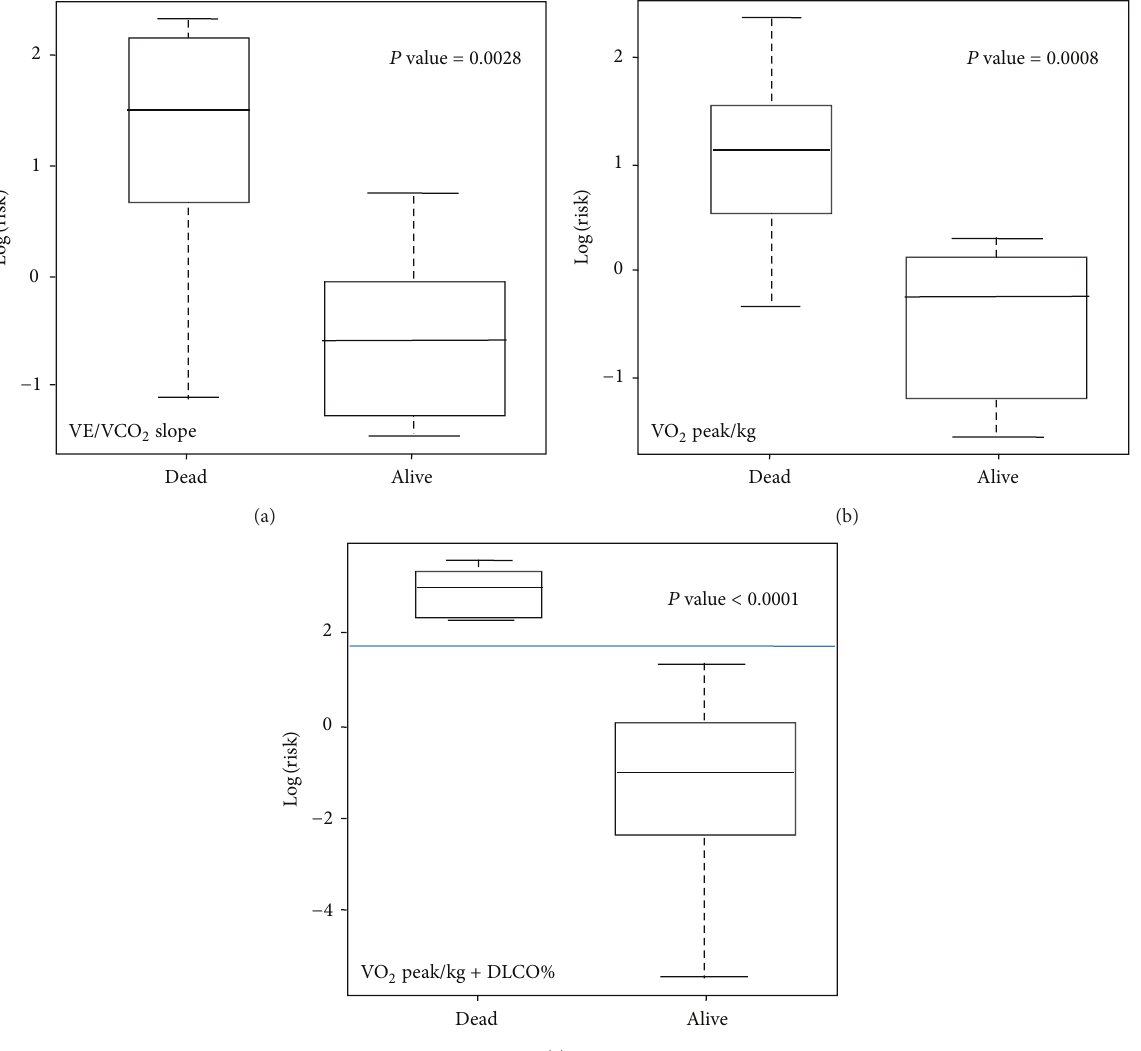
Figure 2: Overall death risk through the Cox proportional hazards models. In box plot (a), the Cox model includes only VE/VCO 2 slope, in box plot (b), the Cox model includes VO 2 peak/kg, and in box plot (c), the Cox model includes VO 2 peak/kg + DLCO%. A bidirectional stepwise model selection method minimizing the Bayesian information criterion (BIC) was utilized for selecting the optimal model which was identified as VO 2 peak/kg + DLCO%. Data are described using standard box plots with medians (interquartile range). Risk was found to be significantly differentiated between dead and alive with 𝑃 = 0.0028 , 𝑃 = 0.008 , and 𝑃 < 0.0001 , respectively. Table 4: Relationships between the variables of 6MWT and slope and VO peak/kg by Spearman’s rank correlation VE/VCO 2 2 coefficient. 𝑃 value < 0.05 is considered significant. VO peak/kg VE/VCO slope 2 2 𝑟 = 0.7 𝑟 = −0.6 Distance 𝑃 < 0.0001 𝑃 = 0.001 𝑟 = −0.52 𝑟 = 0.4 Desaturation% 𝑃 = 0.007 𝑃 = 0.02 Minute ventilation (VE), carbon dioxide output (VCO 2 ), and peak oxygen consumption/kg (VO 2